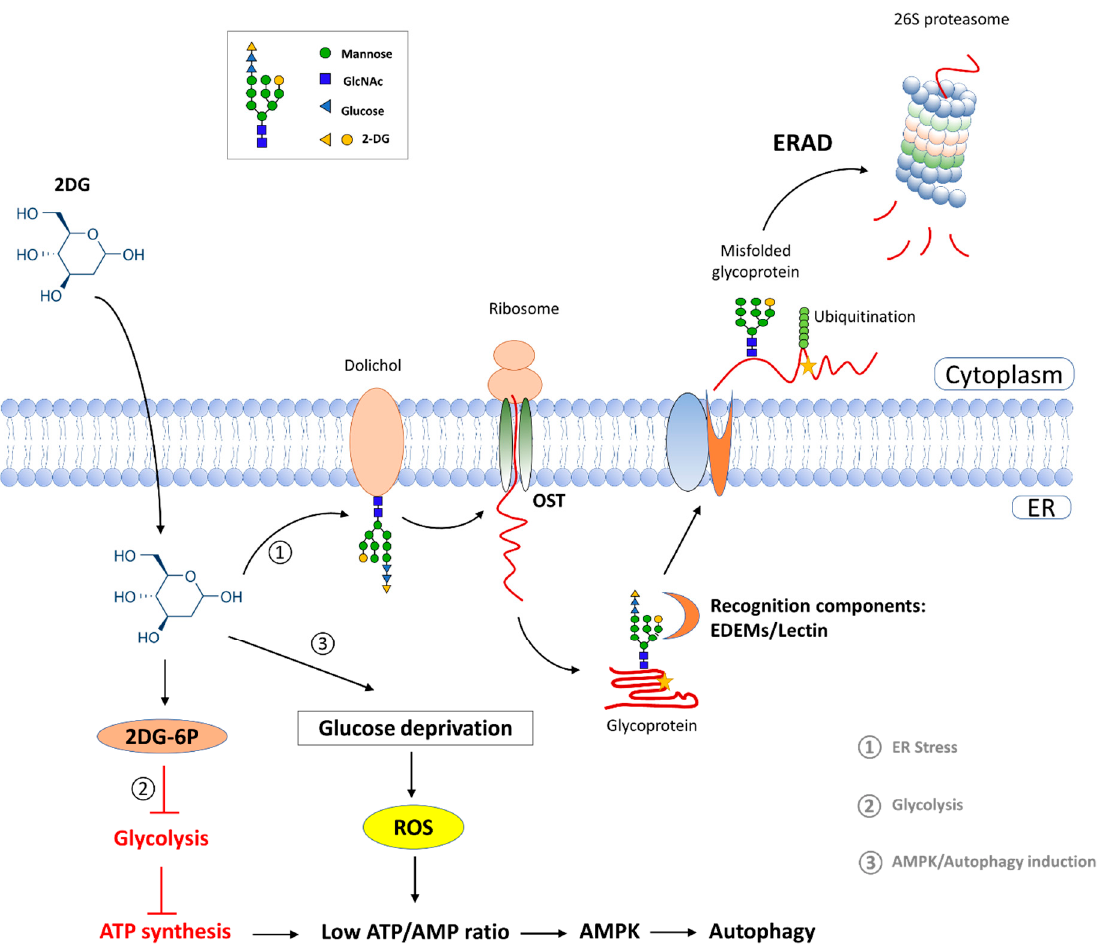
Figure 6. The influence of 2-Deoxy-D-glucose (2DG) on tumor cells. 2DG inhibits the growth and survival of cancer cells by interfering with the ATP produced by the metabolism of D-glucose. In addition, 2DG can inhibit protein glycosylation in vivo by competing with D-mannose, leading to endoplasmic reticulum (ER) stress and misfolded protein responses in cancer cells.